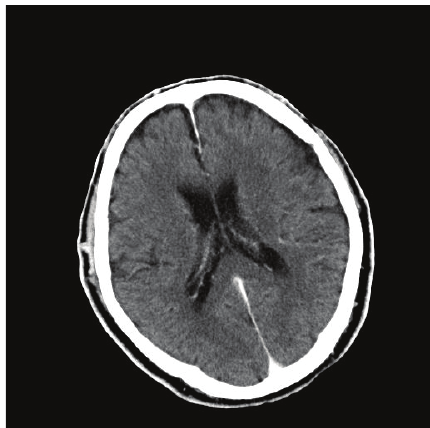
Figure 1: CT of the brain with intravenous contrast on the first day of admission showing no intracranial pathology, no hydrocephalus, and no brain abscess formation.